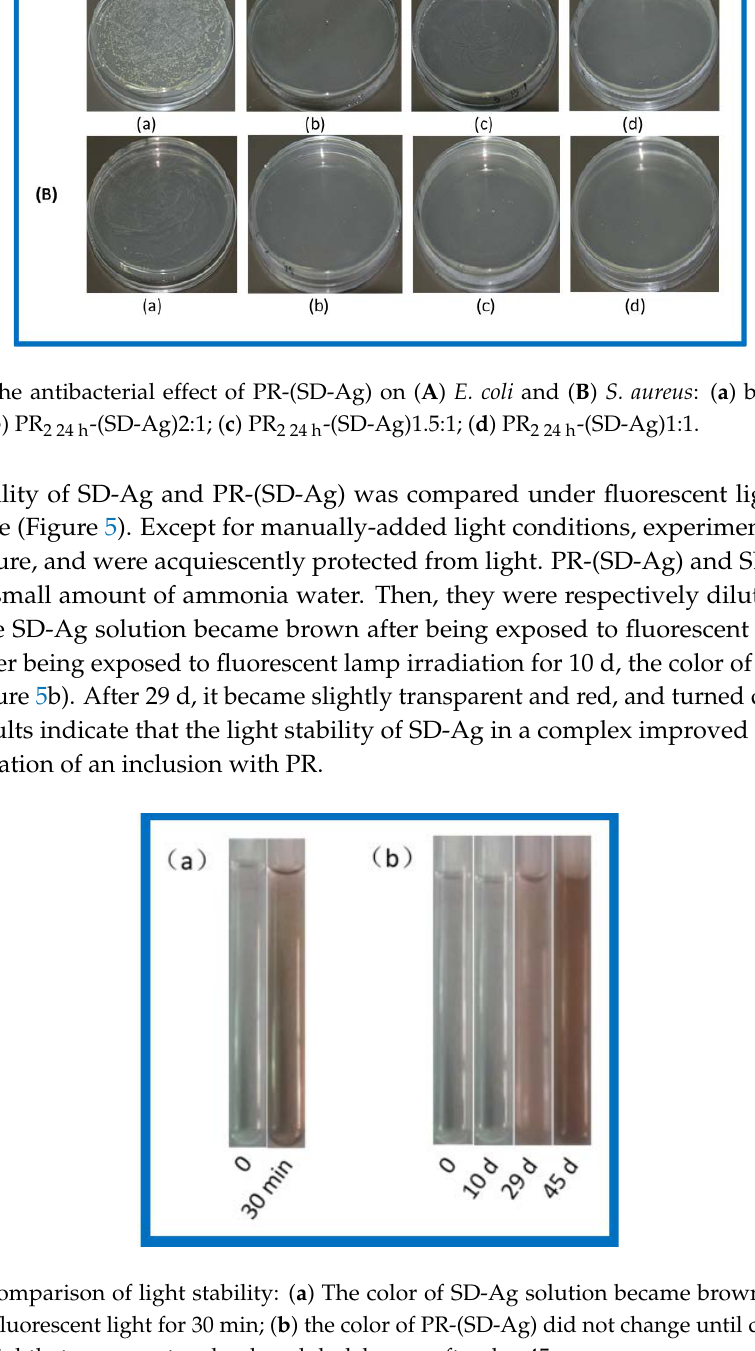
Figure 5. Comparison of light stability: ( a ) The color of SD-Ag solution became brown after being exposed to fluorescent light for 30 min; ( b ) the color of PR-(SD-Ag) did not change until day 29, when it became slightly transparent and red, and dark brown after day 45.